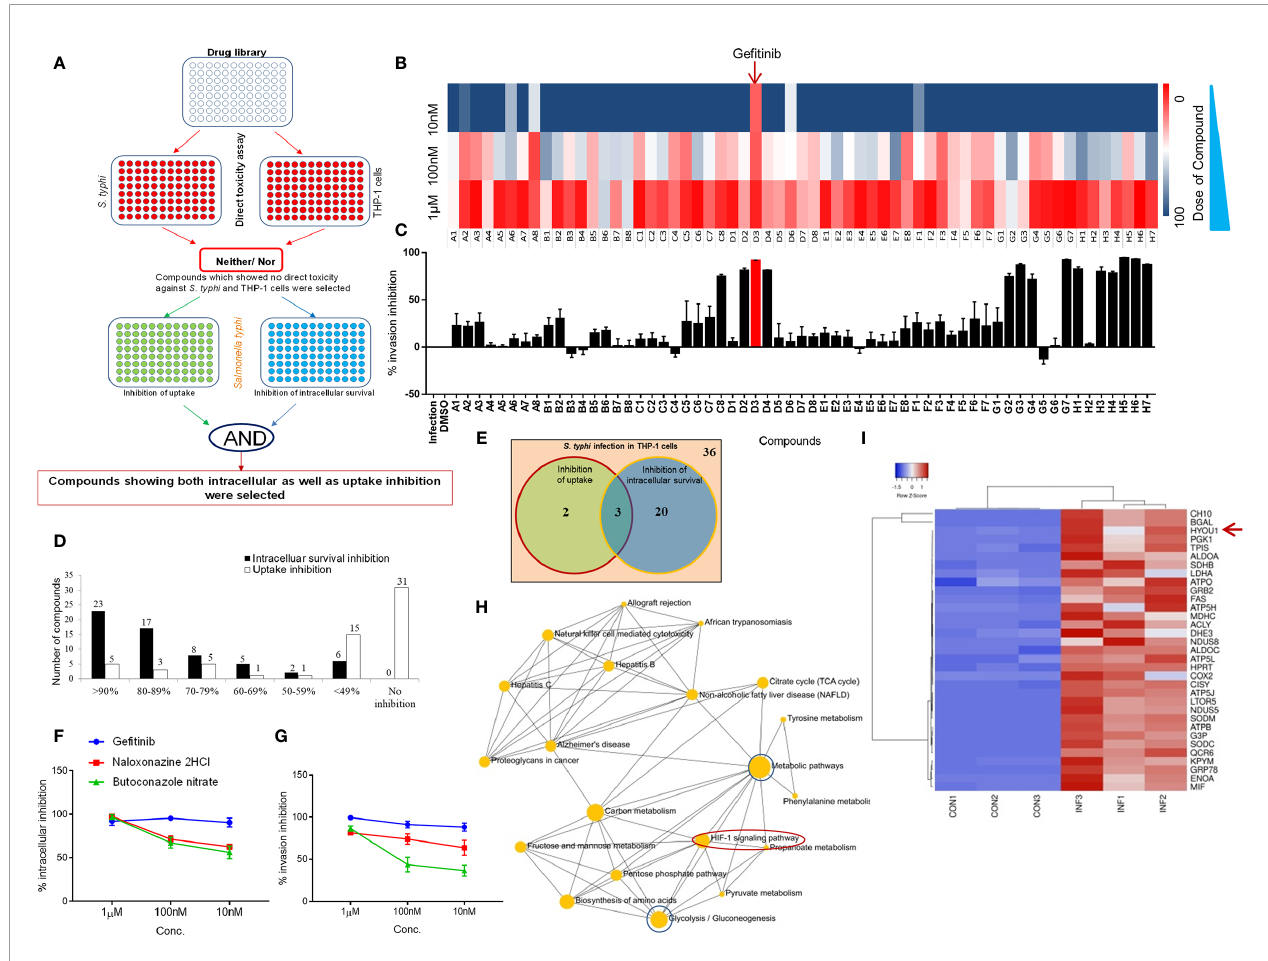
FIGURE 1 | EGFR signaling essential for the survival of Salmonella within macrophages. Panel (A) representative strategy for the screening of ENZO compound library. (B) Intracellular replication as % inhibition was evaluated at different concentration (1µM, 100nM & 10nM) and plotted as intensity heatmap. Panel (C) represents % inhibition ± SEM upon pre-exposure of compounds (1µM) plotted as bar graphs. (D) The number of hits in the form of compounds showing good inhibition was plotted as a bar graph. (E) Venn diagram showing the number of compounds with ≥ 90% inhibition and 3 overlapping compounds with signi fi cant inhibition for both intracellular survival and internalization. These 3 compounds were further tested for intracellular and internalization inhibition in a dose kinetics assay ( F, G respectively). (H) Network analysis of control and infection conditions. (I) Heatmap analysis of a subset of top signi fi cantly expressed genes in Control vs Infection. Data are representative of mean ± SEM from three replicates and each individual experiments repeated three